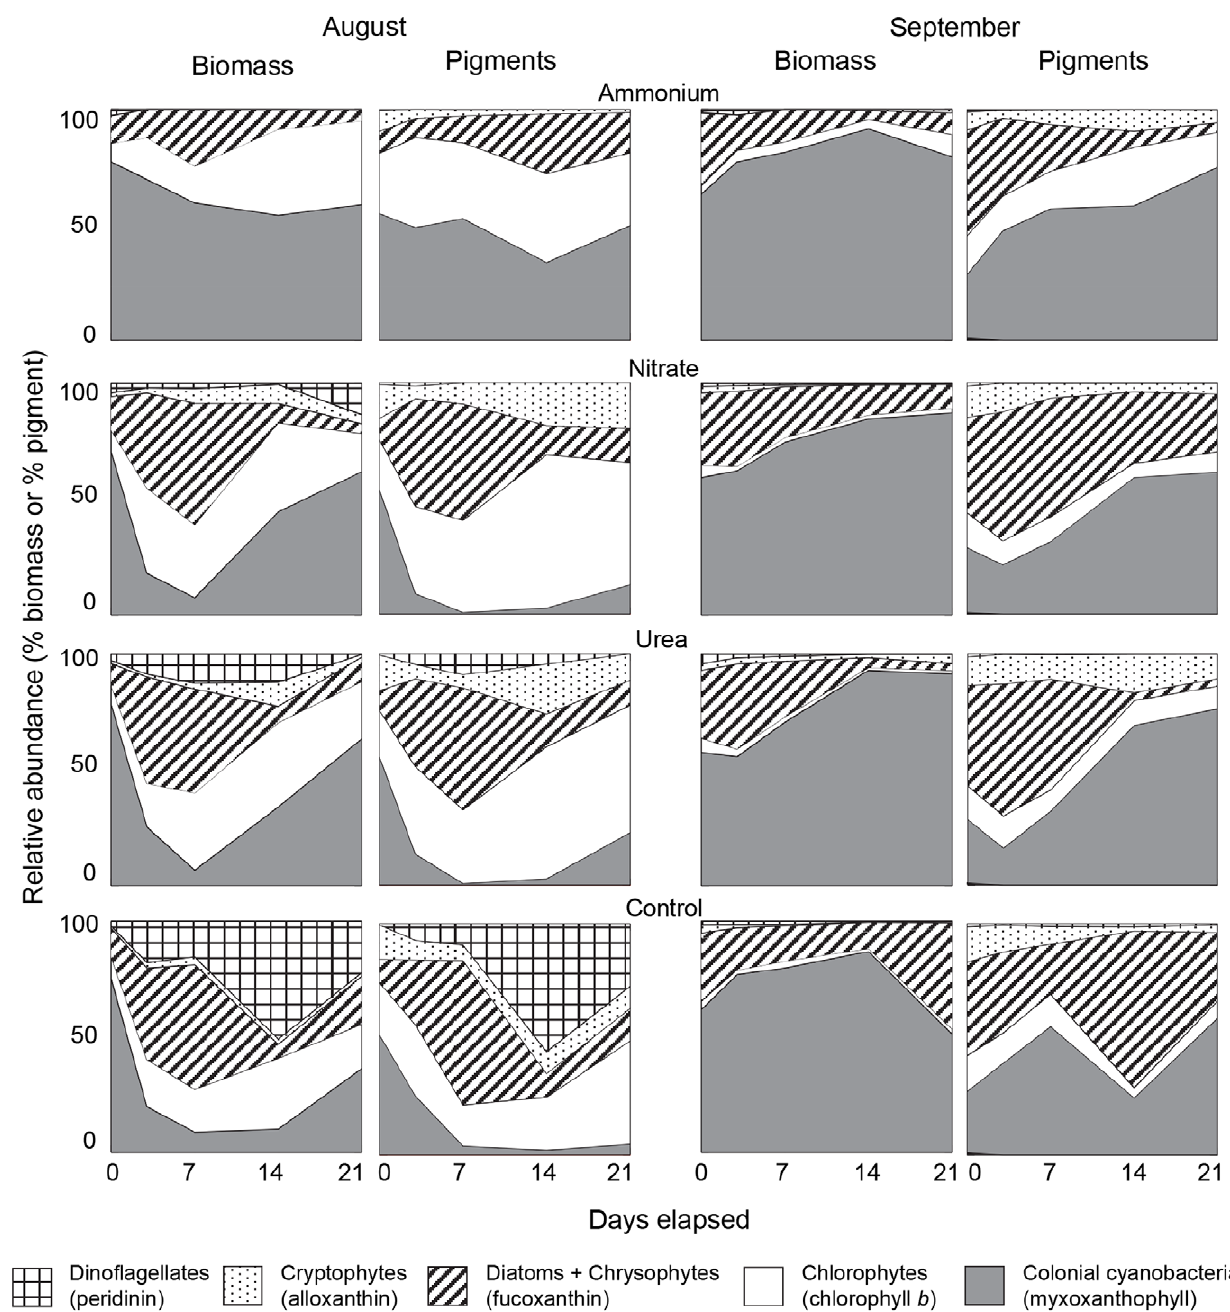
Figure 6. Mean relative abundance of the major phytoplankton groups in the mesocosms subject to addition of nitrogen. Treatment include addition of ammonium, nitrate, urea and no nitrogen (control) (n=3). Phytoplankton abundance was determined by microscopic enumeration of biomass and by high performance liquid chromatography of algal pigments in experiments conducted during August and September 2008. Algal groups (and pigments) include dinoflagellates (peridinin), cryptophytes (alloxanthin), diatoms and chrysophytes (fuoxanthin), chlorophytes (chlorophyll b ) and colonial cyanobacteria (myxoxanthophyll).